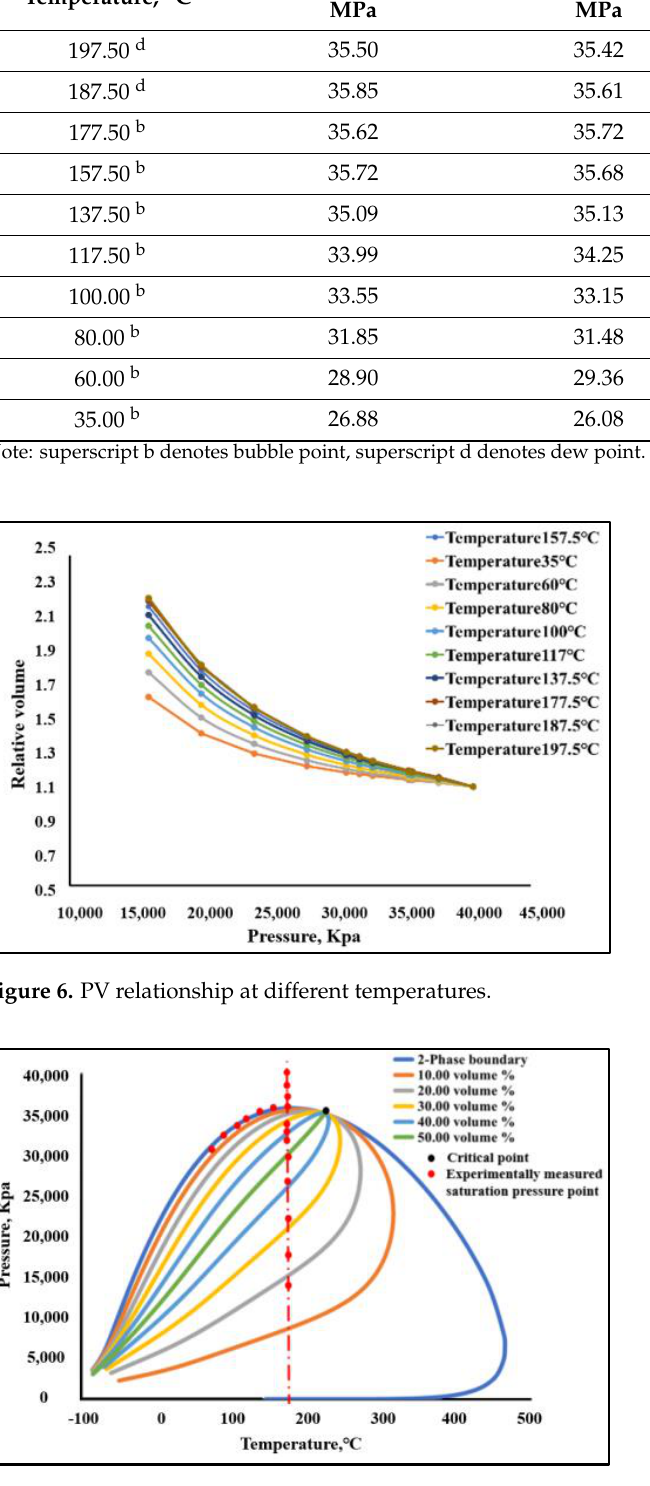
Figure 7. P-T phase diagram of formation fluid.